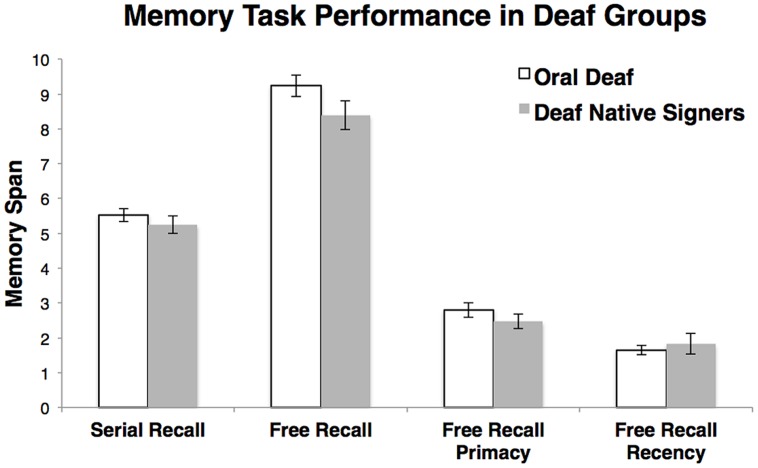
Memory task performance. Error bars represent the SE of the mean.